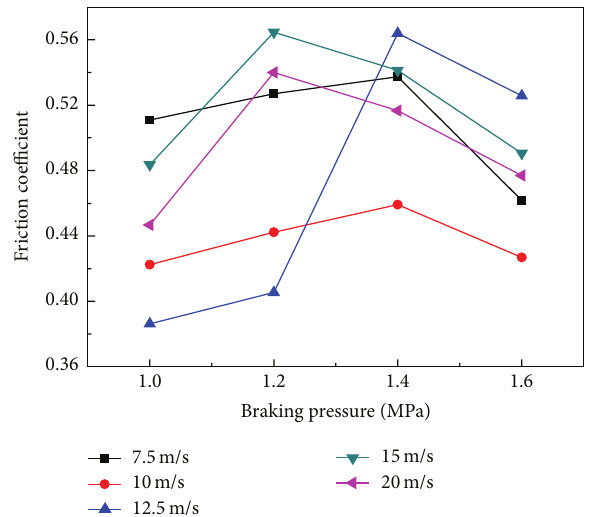
Figure 7: Variations of the mean friction coefficient with braking